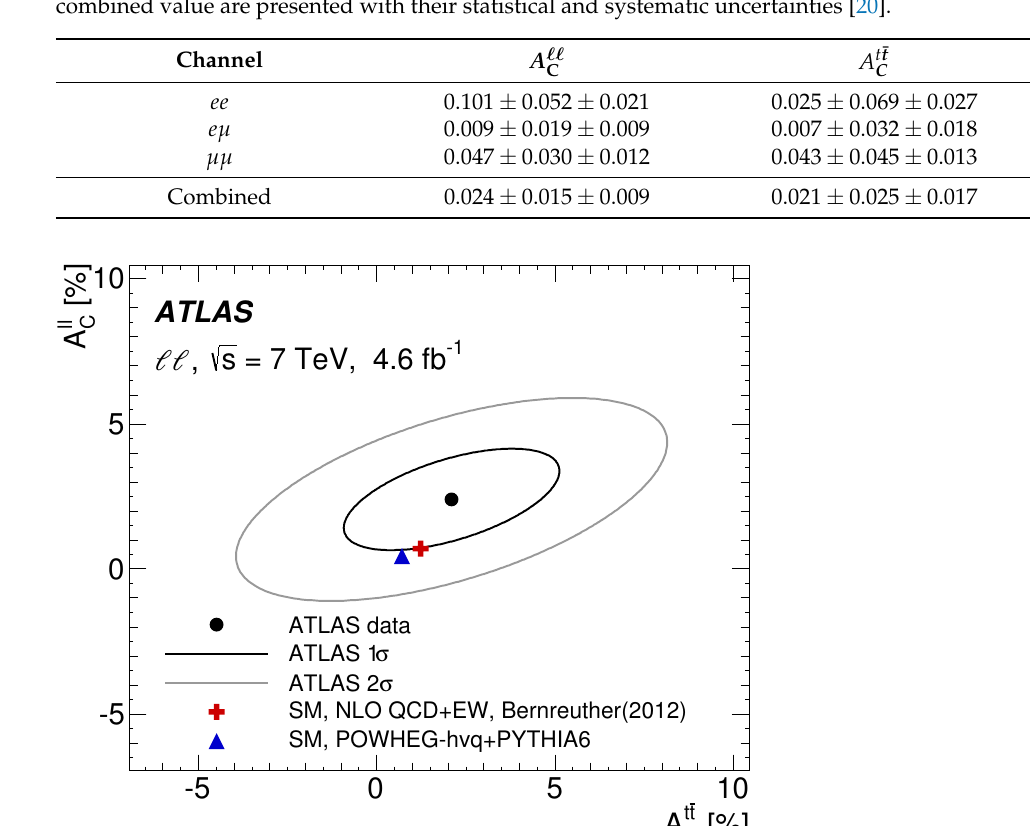
and the t ¯ t asymmetry A t ¯ t after correcting for C C